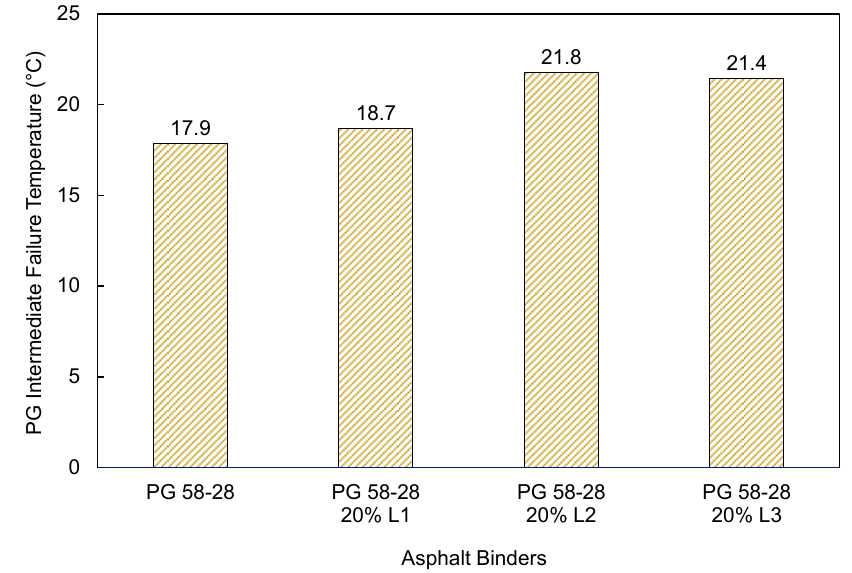
Figure 8. Intermediate Failure Temperature (IT) Values of PAV-Aged Binder Blends.